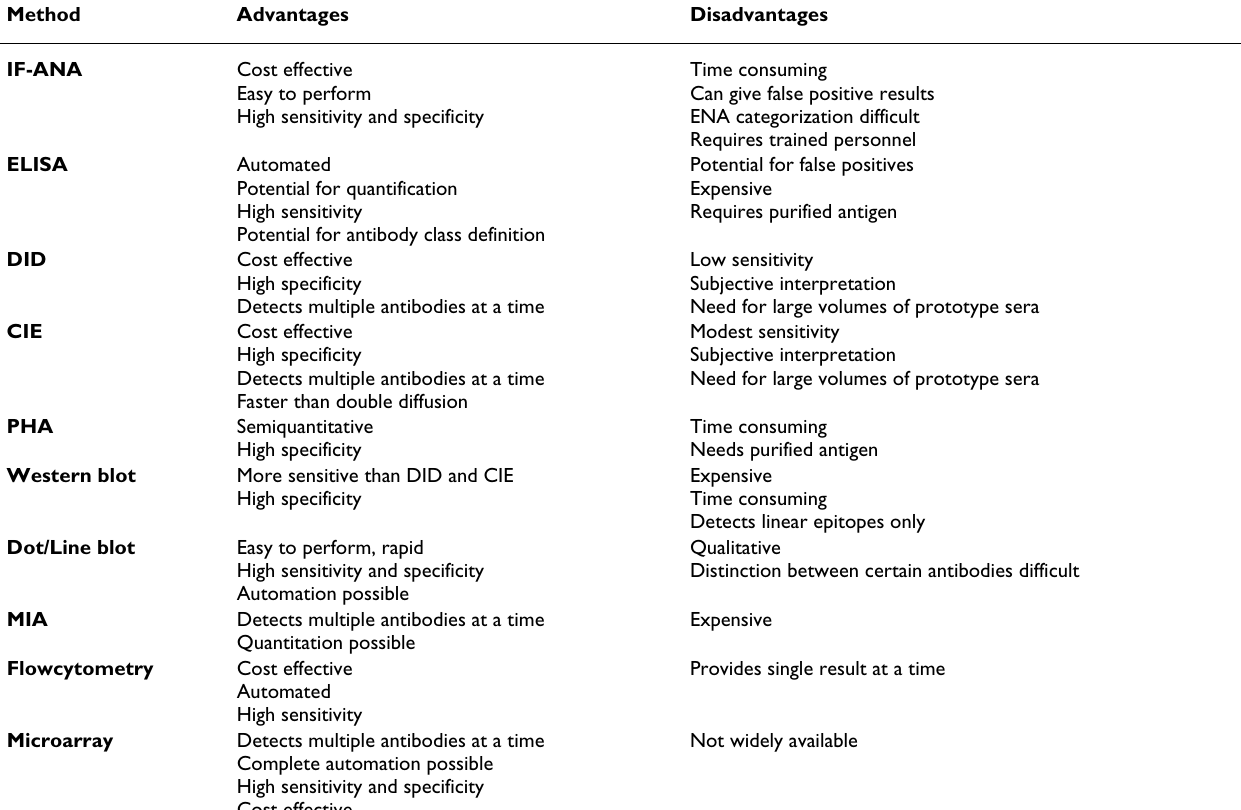
Table 4: Performance of various tests used for detection of specific antibodies